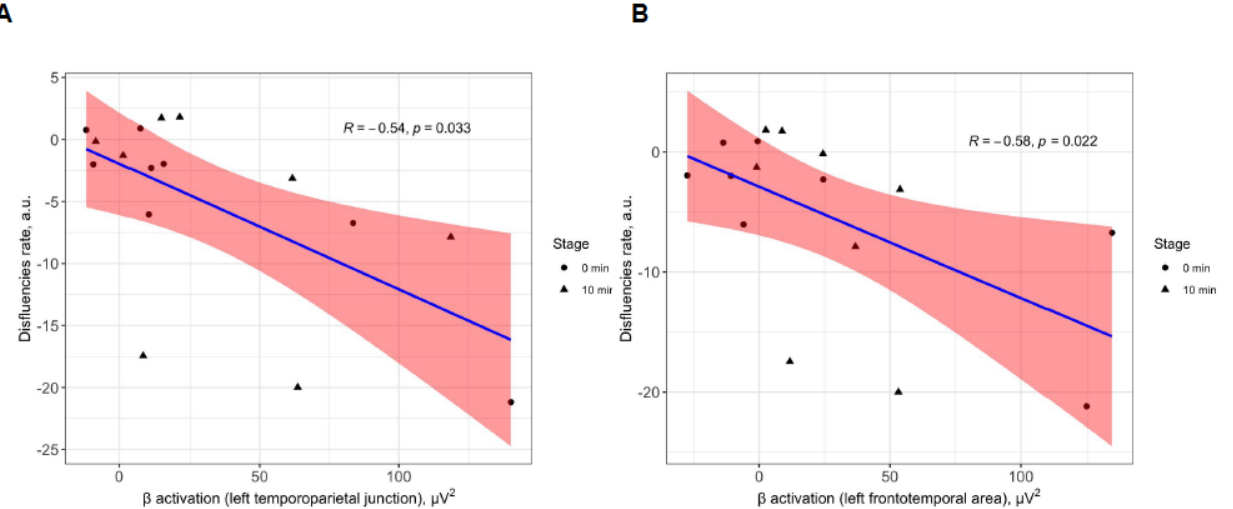
Figure 6. Correlation between speech disfluencies and β -power over the speech-relevant centers after binaural beats stimulation (0 min and 10 min after). ( A ) Correlation between disfluency rate per AWS participants and β -band power average across electrodes over the LTP junction. ( B ) Correlation between disfluency rate per AWS participants and β -band power average across electrodes over the LFT area. Abbreviations: AWS — adults with stuttering; LTP — left temporoparietal junction; LFT — left frontotemporal area.